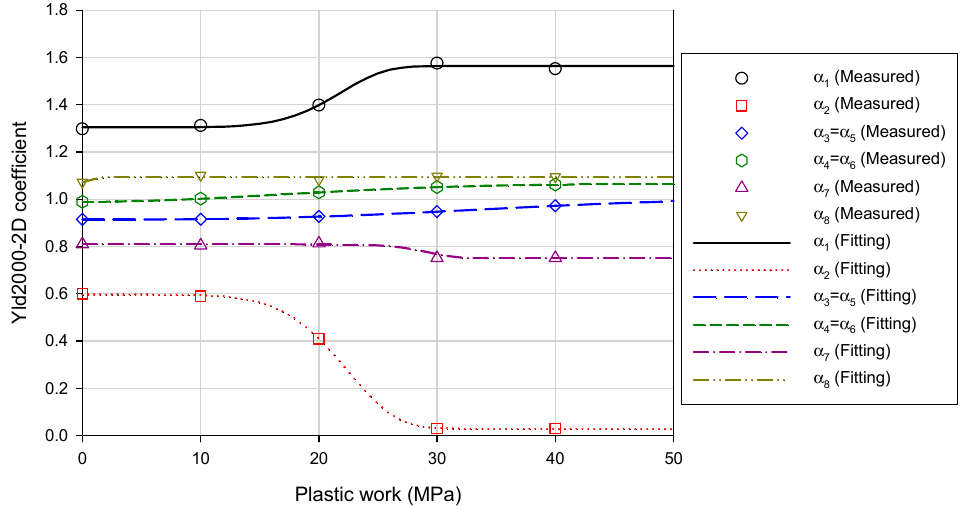
Figure 10. Evolutions of the parameters of yield function (Yld2000-2d function) for the niobium sheet with respect to the plastic work.